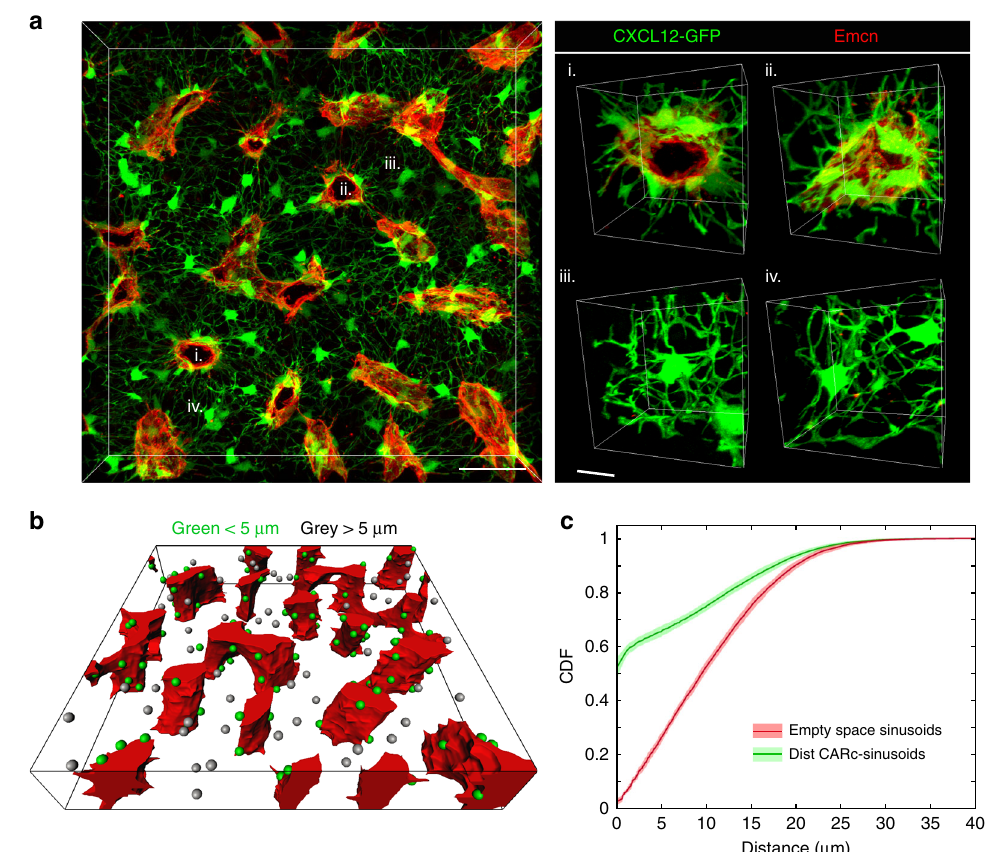
Fig. 6 CARcs accumulate in close physical contact with sinusoidal vessel walls. a Representative 3D image of BM tissues depicting immunostained sinusoidal vessels (red) and GFP + CARcs (left). Scale bar, 50 µ m. Right panels show higher magni fi cation images of perisinusoidal clusters of CARcs (top) and examples of large, non-perivascular CARcs (bottom) Scale bar, 10 µ m. b Rotated 3D view of a rendered volume from the segmented image in a , in which CARc subsets are classi fi ed and colour coded according to distance to nearest sinusoid. From the quantitative analysis, two populations of perisinusoidal and non-perisinusoidal are evident (non-perisinusoidal > 5 µ m distance from CARc surface to closest sinusoidal surface). c Side-by-side comparison of the CDF of the distance to nearest sinusoid evaluated at all positions, as well as evaluated at CARc centroids. Solid lines represent mean distance and envelopes indicate standard deviations. Graphs correspond to the pooled data from a total of 3 different regions per bone and 6 different bones. Statistical signi fi cance was analysed using two-sample Kolmogorov – Smirnov and P < 10 − 42 for all